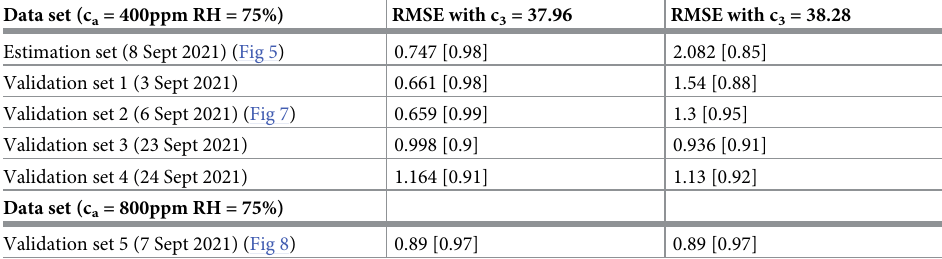
Table 4. Greenhouse data measured under natural fluctuating irradiance. Summary of RMSEs computed to assess ffiffiffiffiffiffiffiffiffiffiffiffiffiffiffiffiffiffiffiffiffiffiffiffiffiffiffiffiffiffiffiffiffiffiffiffiffi P q the accuracy of A n . Here RMSE ¼ ð A (cid:0) A Þ 2 = N , with the measured output denoted by A n,m . Results compar- n n ; m ing the use of the optimised parameter c 3 = 37.96 to the original c 3 = 38.28 [28] are shown. Experiments were con- ducted under 2 sets of ambient CO 2 concentrations, 400ppm and 800ppm, respectively. R 2 values are given in []. Data set (c a = 400ppm RH = 75%) RMSE with c 3 = 37.96 RMSE with c 3 =